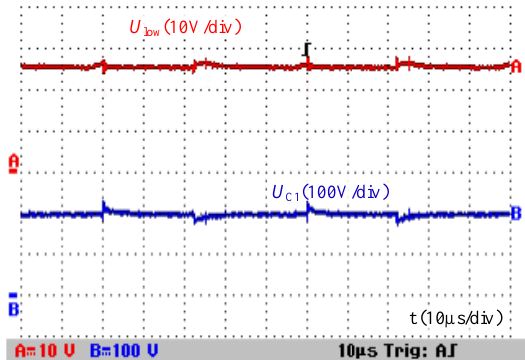
Figure 18. Gate signal and voltage stress of synchronous rectification power semiconductor Q 1 .